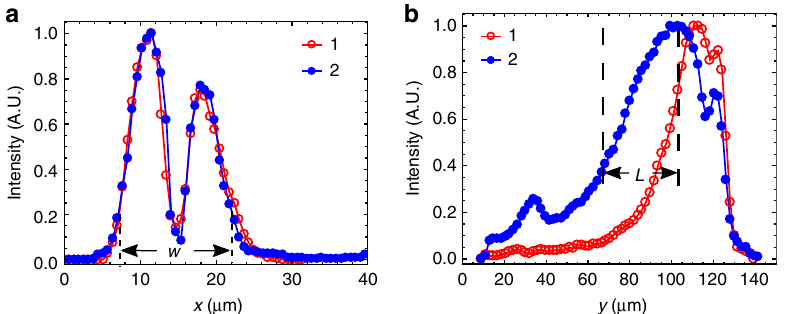
Fig. 3 Width and length of bullets. a Transmitted light intensity measured across two bullets, “ 1 ” ( f = 500 Hz, U = 41.2 V) and “ 2 ” (850 Hz, 56.4 V) in the same cell with d = 7.8 µ m; the pro fi le is measured as a function of x -coordinate along the line that passes through the transmission maximum (such as line i = 33 in Fig. 1b). b Longitudinal pro fi les of the same 1 and 2 bullets, measured as a function of y -coordinate along the line that passes through maximum transmittance (such as line j = 14 in Fig. 1b). Note that the width w shows practically no dependence on the applied voltage, while the length L increases with voltage